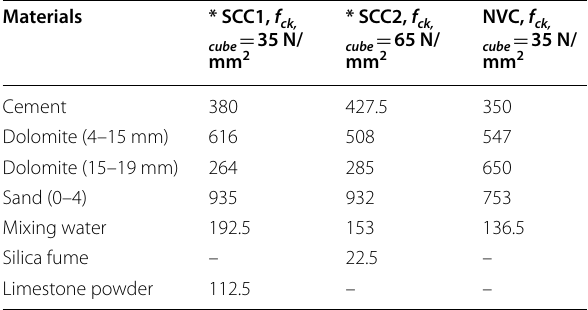
Table 2 Mixture proportions for SCC1, SCC2 and NVC (kg/m 3